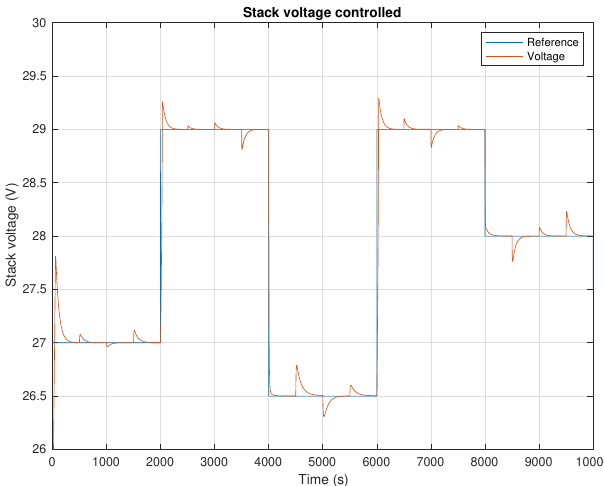
Figure 23. Stack voltage profile during the simulation.